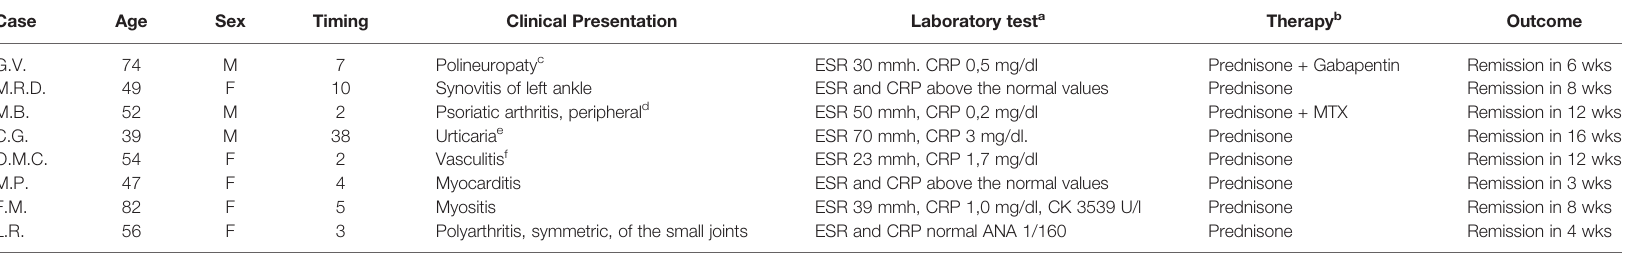
TABLE 4 | Immune-Mediated Diseases (IMDs) diagnosed in outpatients previously hospitalized for COVID-19 and in follow up. Case Age Sex Timing Clinical Presentation G.V. 74